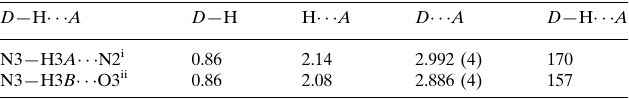
Hydrogen-bond geometry (A˚ , (cid:2)